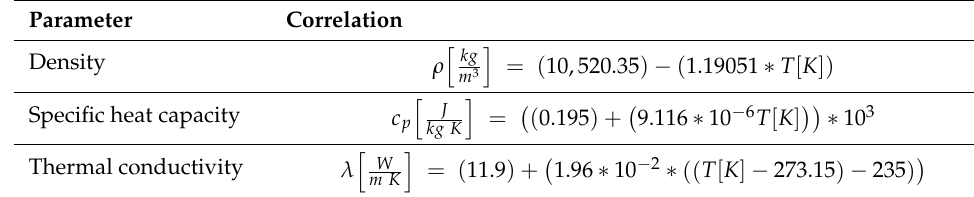
Table 2. PbLi thermo–physical properties.